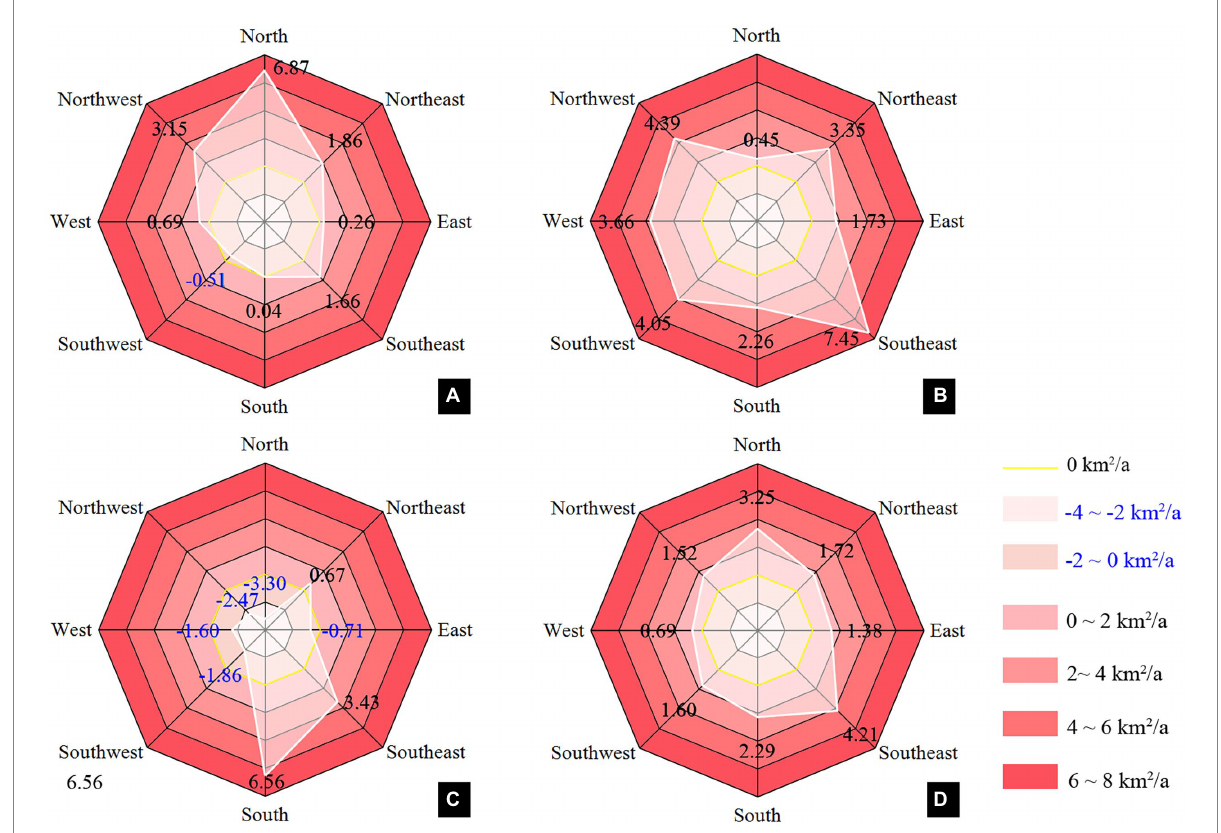
FIGURE 7 The expansion direction of the annual mean LST-night [where, (A) 2001–2007; (B) 2007–2013; (C) 2013–2018; (D)